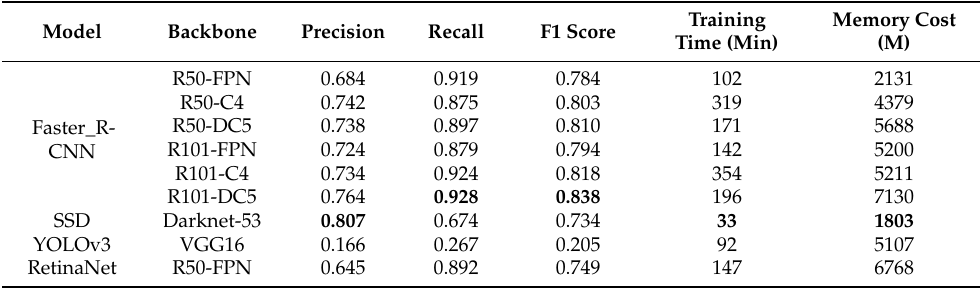
Table 2. Oil well detection evaluation metrics (Precision, Recall, and F1 score) (Intersection over Union ( IoU ) = 0.5). The bold font indicates the best